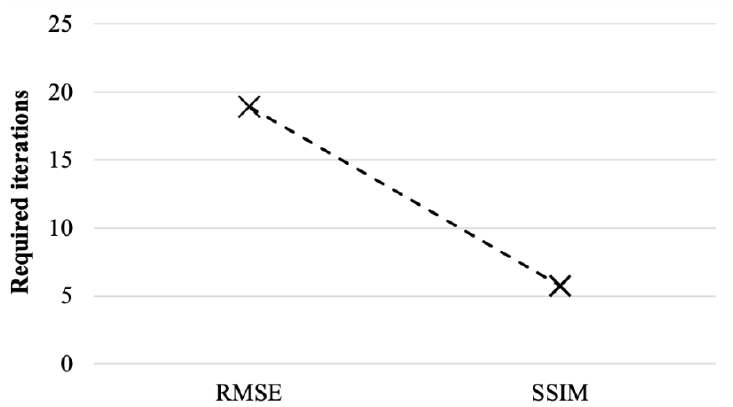
Figure 14. The average calculation time required for FiDOC algorithm using RMSE or SSIM as the image quality metrics, based on the McGill Calibrated Colour Image Database.